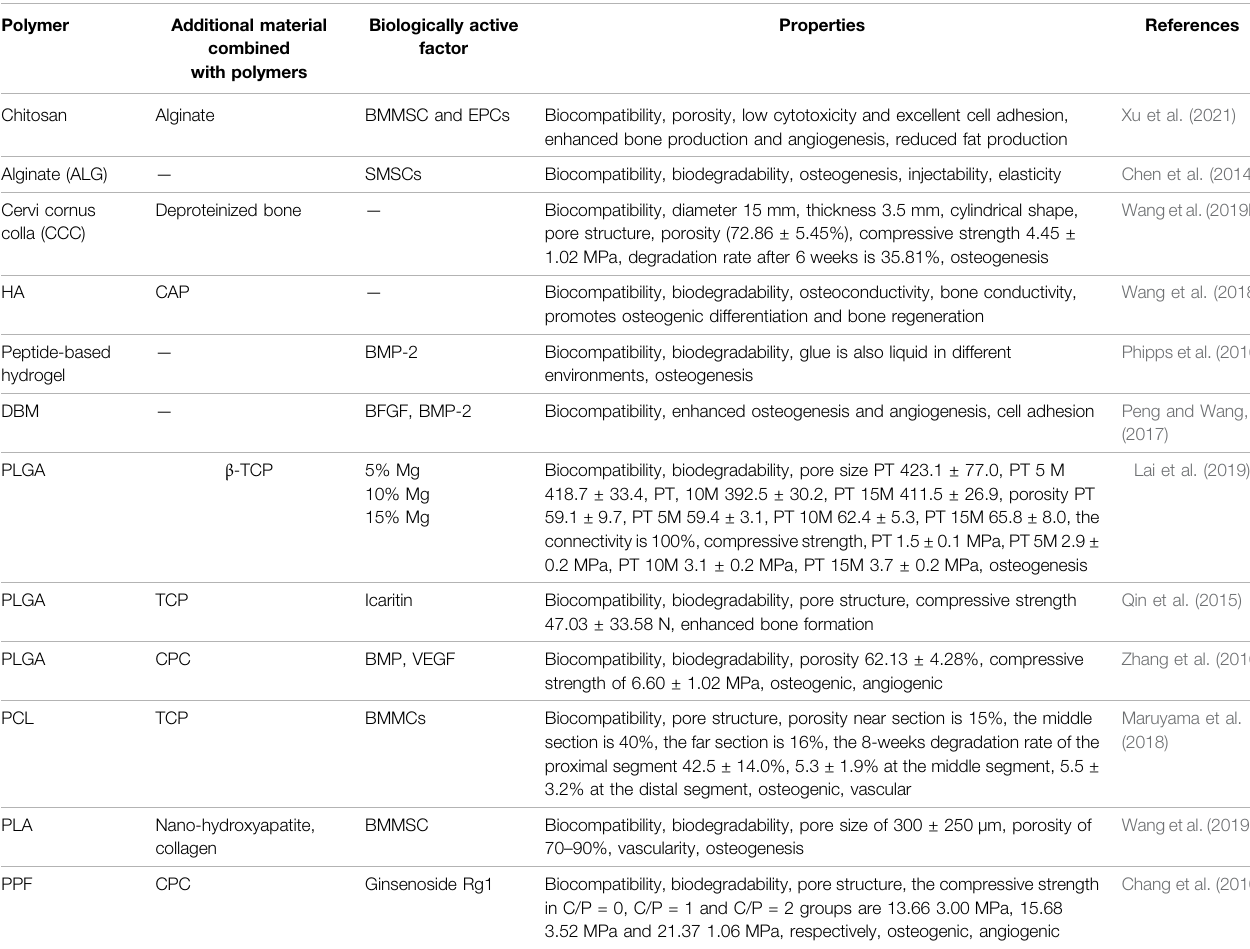
TABLE 1 | Combined application of polymers. Polymer Additional material